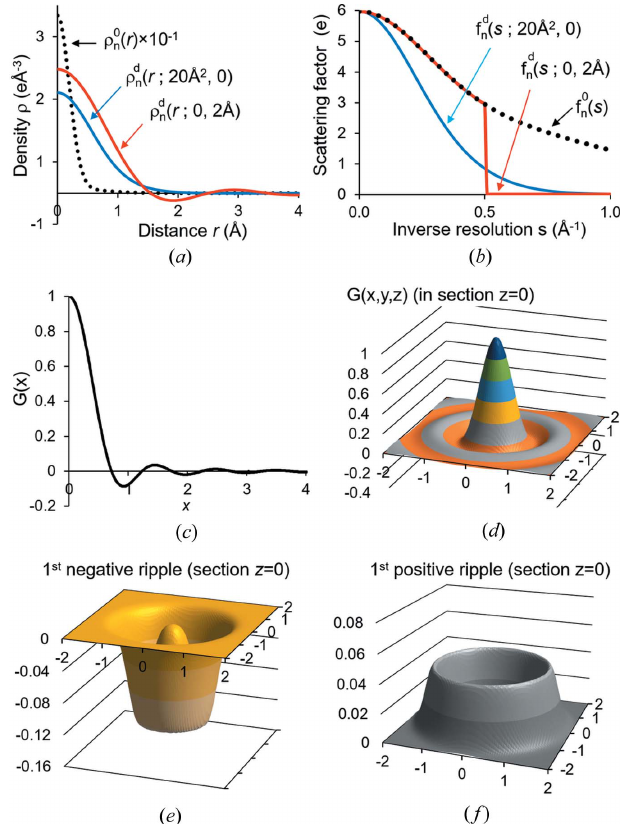
Figure 2 Atomic images and Fourier ripples. ( a ) Electron-density distributions for an immobile carbon atom and its images affected by disorder and resolution cutoff. ( b ) Corresponding scattering functions [Fourier trans- form of the functions shown in ( a )]. ( c ) Radial part of the interference function G ( x ) and ( d ) this function in the two-dimensional section z = 0. Approximation to ( e ) the first negative and ( f ) the first positive ripples of G ( x ) by the weighted functions (cid:2) ( x ; (cid:5) , (cid:6) ) according to Table 1. Two- dimensional section z = 0 is